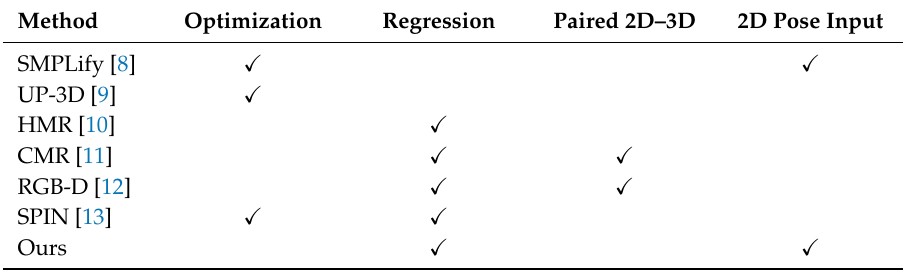
Table 1. Comparison of our proposed method with other previous methods for 3D human body mesh reconstruction. “Optimization” indicates that the method depends on the optimization process, which requires parameter initialization and is generally slow. “Regression” indicates that the method is a deep neural network that requires large-scale training data. “Paired 2D–3D” indicates that paired 2D and 3D data should be used for training. “2D pose input” indicates that a 2D human pose can be used as the input to the method instead of an red, green, and blue (RGB) image. Method Optimization Regression Paired 2D–3D 2D Pose